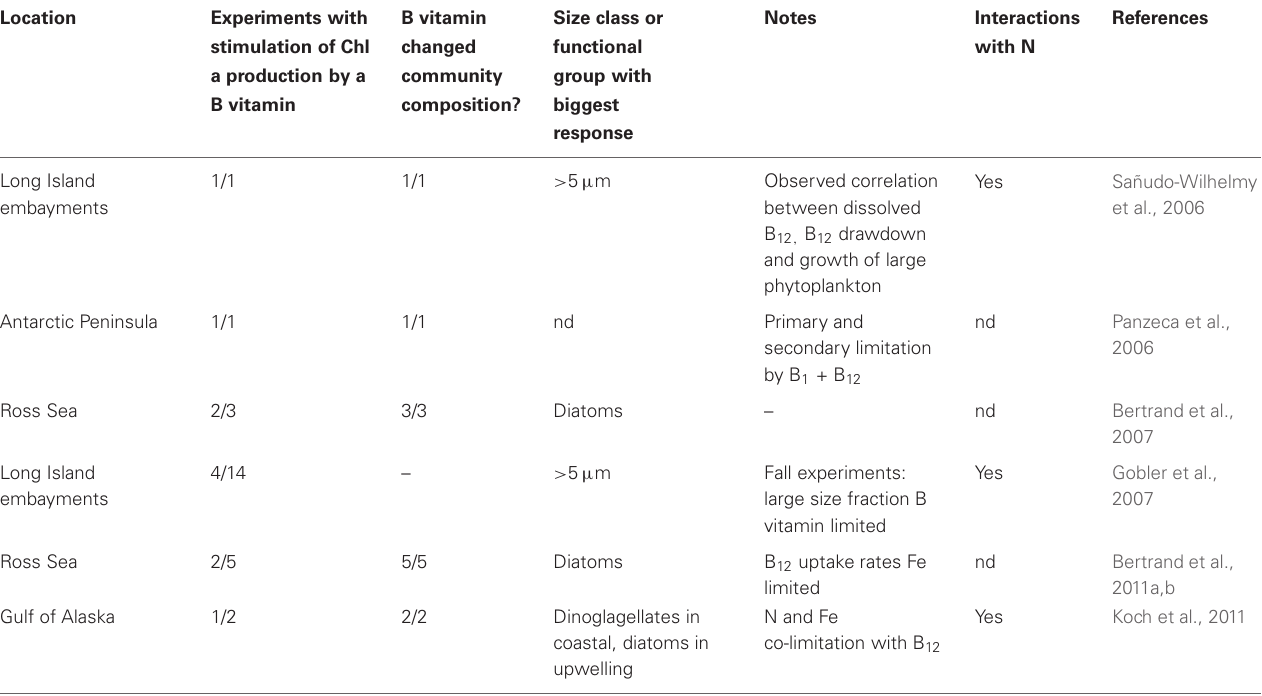
Table 3 | Results of B-vitamin supplementation in published marine bottle incubation bioassays.